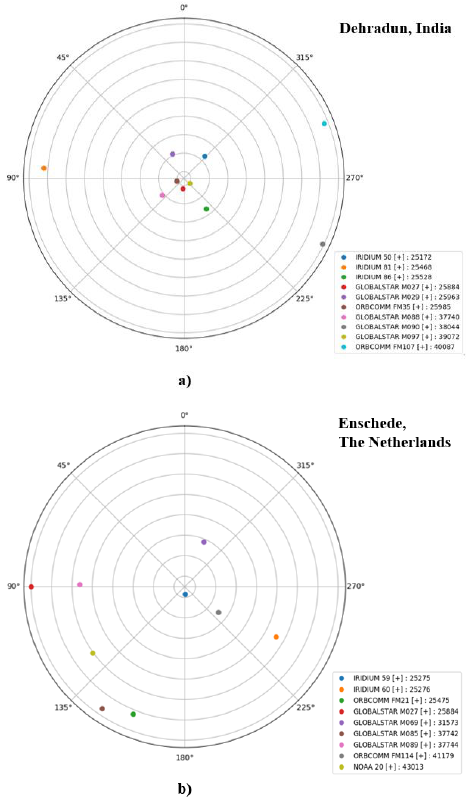
Figure 7: Location-based satellite visualisation as observed in a) Dehradun, India and b) Enschede, The Netherlands.